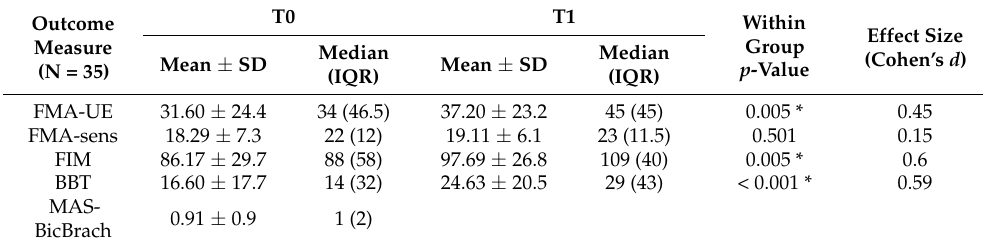
Table 2. Motor outcome measures before (T0) and after (T1)